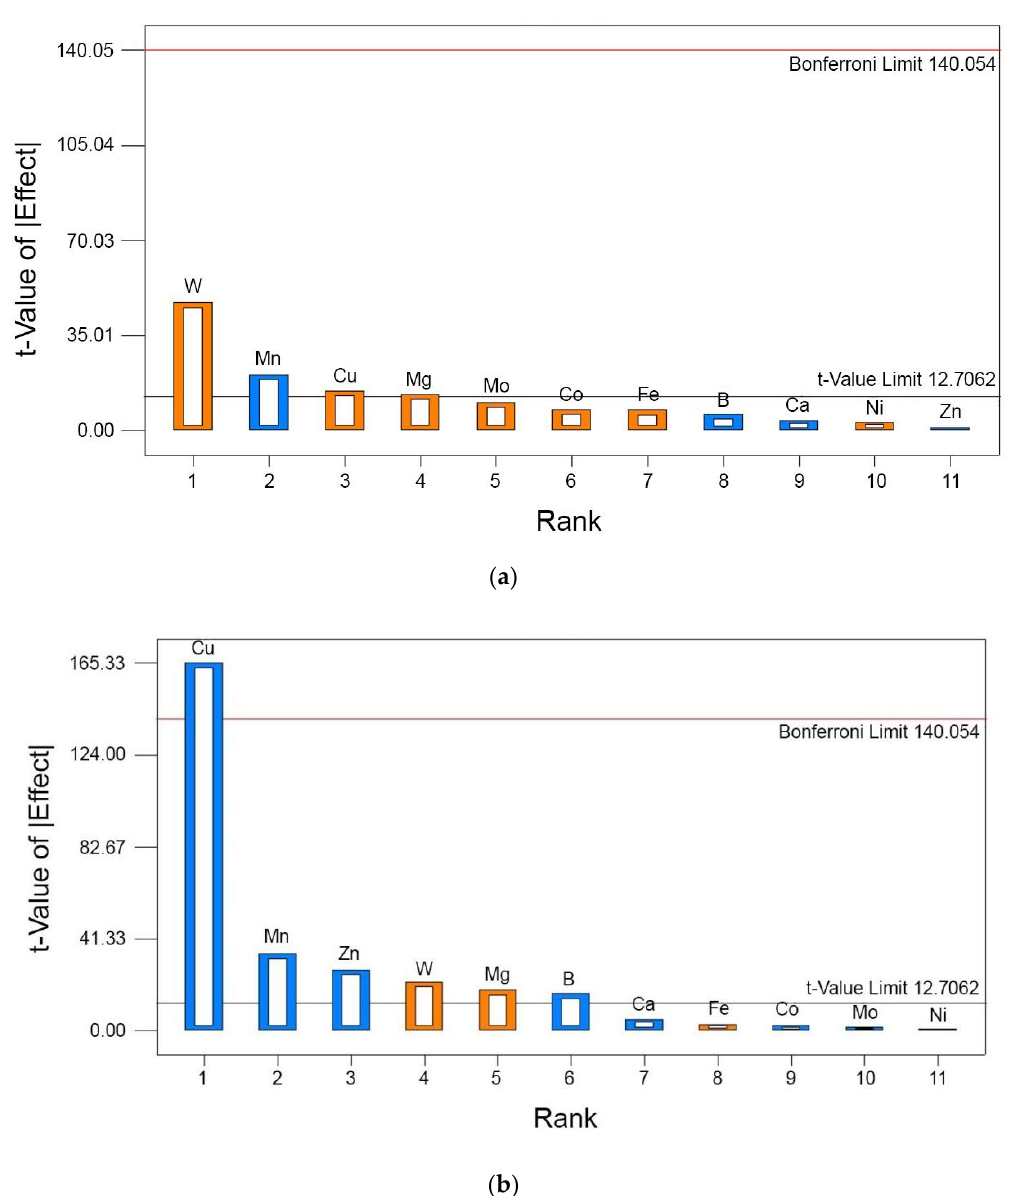
Figure 4. Pareto Charts for effect of trace metals on ( a ) ethanol and ( b ) biomass production.